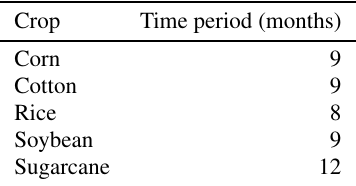
Table 1. Dataset sizes for each crop. Sizes were obtained after removing municipalities with zero yield. The sets were split by adding yield data related to 2018 to the Test set and the remaining data to the Train/Valitation set.